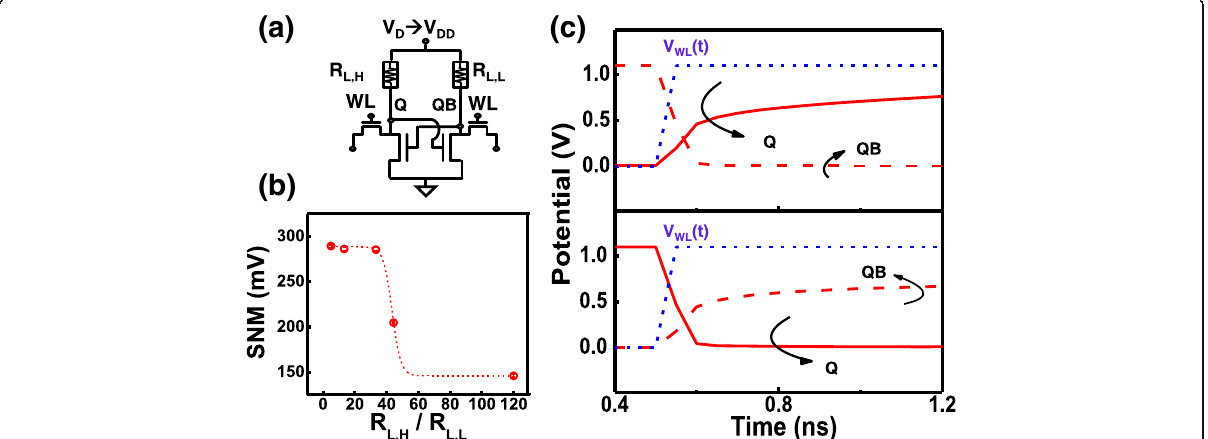
Fig. 10 a Cross-couple structure during unbalance load. b Static noise margin with different WL voltages during initialization. c Dynamic write for two different data states. Unbalance R L,L = 400 k Ω can also be